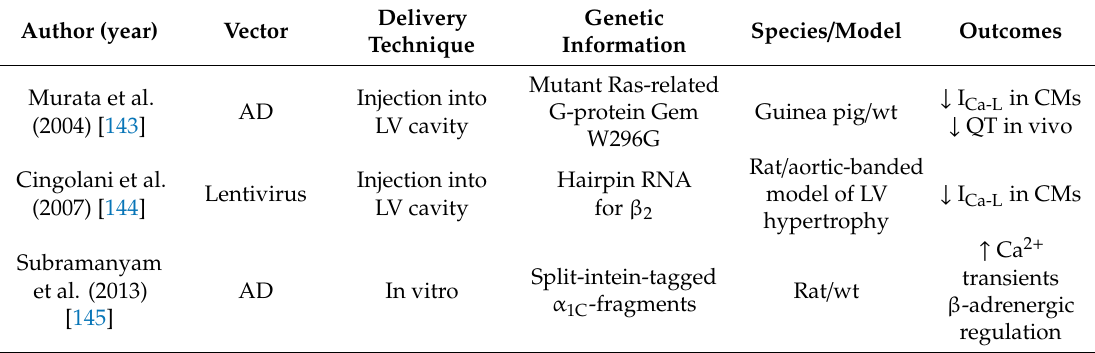
Table 2. Gene therapies for ventricular tachycardia targeting L-type Ca 2 + channel